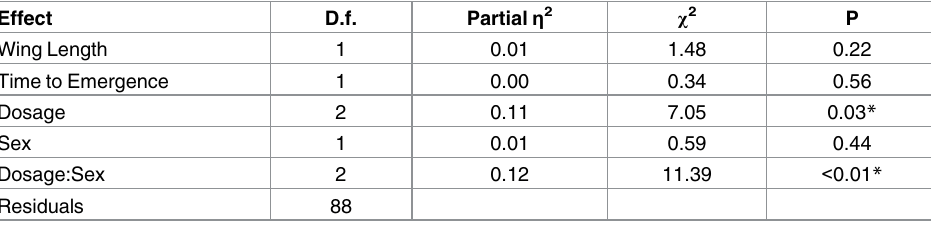
Table 3. ANCOVA results for the response variable percentage of oocysts in the adult and the explan- atory variables of sex and parasite dosage, with covariatesof wing length and time to emergence, and a random effect for